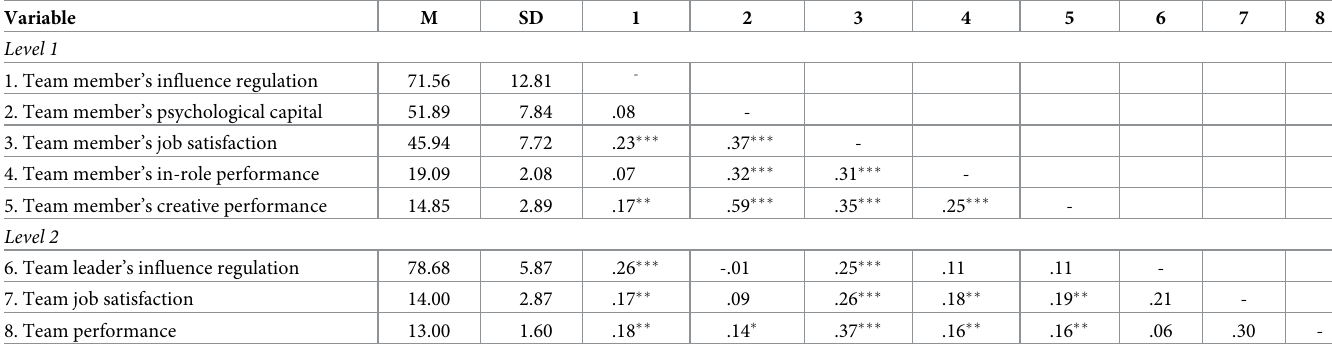
Table 1. Descriptive statistics and intercorrelations among the study variables. Variable